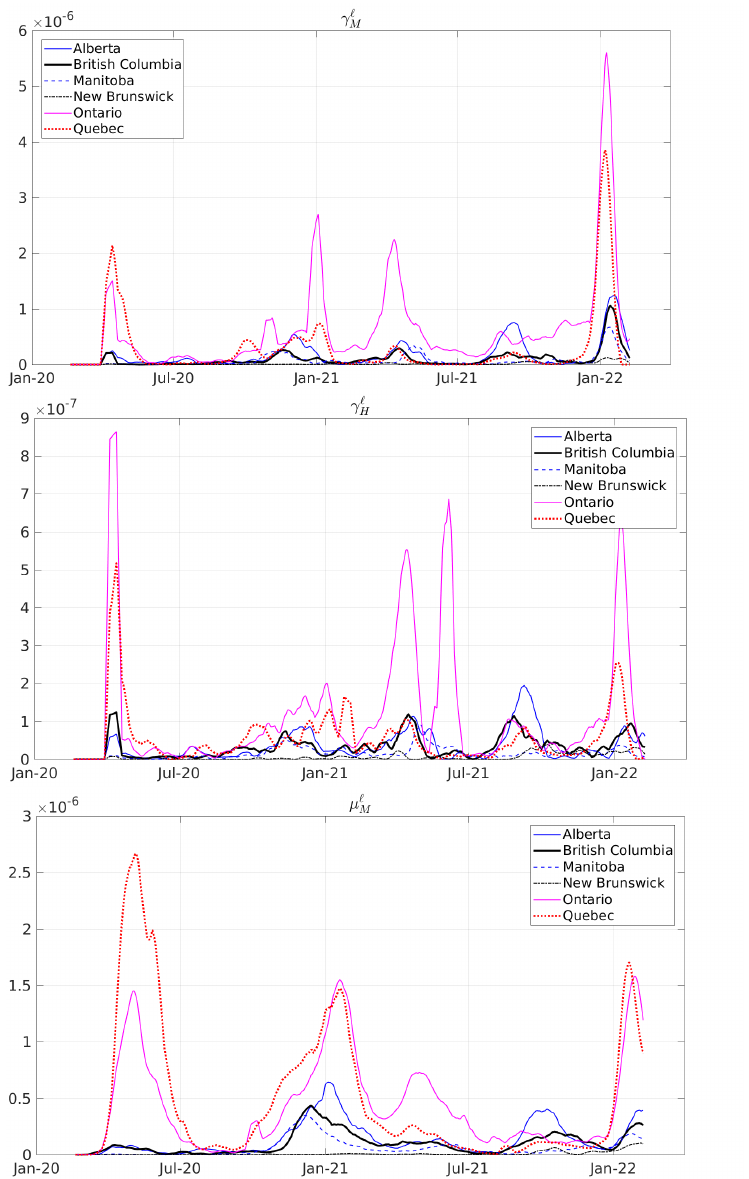
Figure 2. 7-day moving average of the time series of the estimated values of the hospitalization rate ( t ) , ICU admissions rate γ (cid:96) ( t ) , and the death rate from mild infections µ (cid:96) γ (cid:96) M H Columbia, Manitoba, New Brunswick, Ontario, and